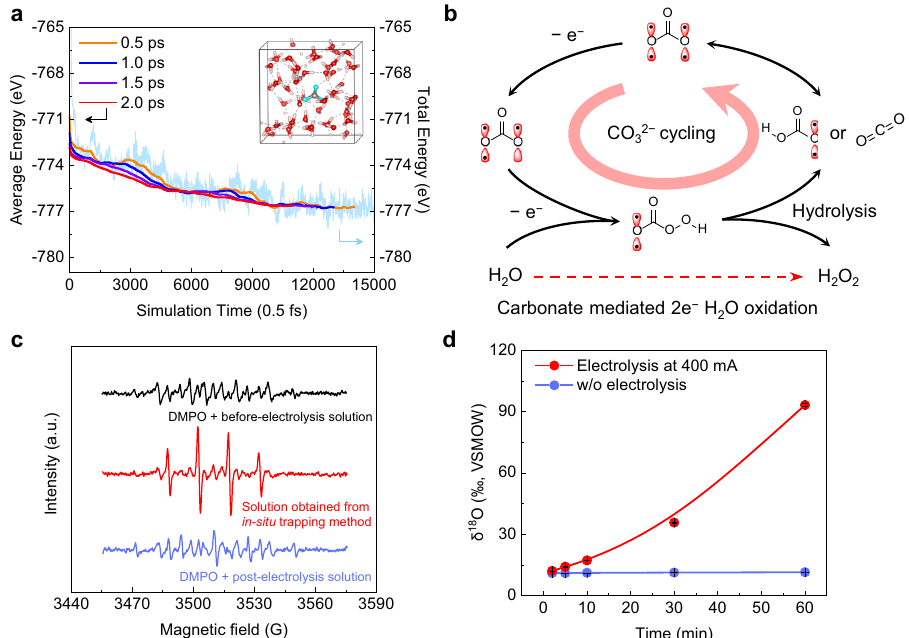
Fig. 4 Molecular understanding of the reaction mechanism and experimental detection of key intermediates. a Convergence of average energy of CO 3 (cid:129) − with 50 H 2 O molecules using AIMD. Evaluating average of total energy was done over a varying length of averaging time, from 0.5ps to 2.0ps. The time coordinate for the average energy corresponds to the point from which the averaging window begins (e.g., for an averaging window of 0.5ps, the average that is shown at 500fs corresponds to the average from 500fs to 1,000fs). Cyan, red, light pink, and gray balls represent the O in CO 3 (cid:129) − , the O in H 2 O, H, and C atoms, respectively. b Reaction mechanism of carbonate-mediated 2e − -WOR to H 2 O 2 . Two possible key intermediates, CO 3 (cid:129) − and HCO 4 − , were proposed, to facilitate the 2e − pathway. c EPR spectra of Na 2 CO 3 electrolyte containing DMPO spin trap. Compared to the solutions of non-electrolysis or post-electrolysis, the solution obtained from the in-situ trapping method under electrolysis exhibit a clear four-line 1:2:2:1 splitting pattern characteristic of the DMPO (cid:129) − OH adduct, indicating the formation of carbonate radical intermediates under electrolysis. d 18 O isotope abundance in dried carbonate (Methods) at varied isotope exchange time between Na 2 CO 3 solute and deionized water without or without electrolysis. The 18 O isotope abundance in dried carbonate under WOR conditions was orders of magnitude higher than that of natural exchange background, indicating the C-O bonding dissociation and formation due to the percarbonate hydrolysis step. The error bars represent two independent